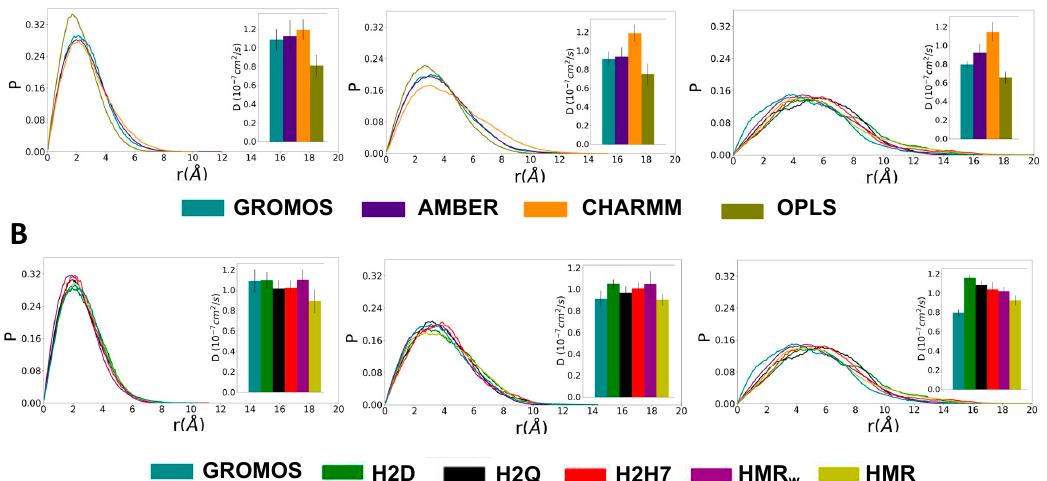
Figure 10. Lateral displacement probability (P) for the SCPN in different time windows for the classical ( A ) and modified ( B ) force fields. The corresponding distributions were fitted to the two-dimensional random walk equation to obtain the corresponding diffusion coefficients, represented in the insets of each graphic.